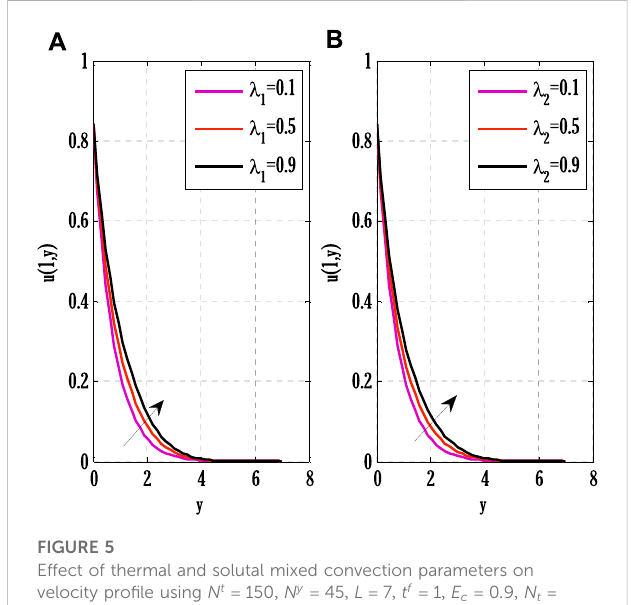
FIGURE 5 Effect of thermal and solutal mixed convection parameters on velocity pro fi le using N t (cid:2) 150 , N y (cid:2) 45 , L (cid:2) 7 , t f (cid:2) 1 , E c (cid:2) 0 . 9 , N t (cid:2) 0 . 1 , N b (cid:2) 0 . 15 , P r (cid:2) 1 , S c (cid:2) 1 , R d (cid:2) 0 . 1 , M (cid:2) 0 . 9 , β (cid:2) 3 , F r (cid:2) 1 . 5 , μ 1 (cid:2) 0 . 05 , λ (cid:2) 0 . 5 , μ 2 (cid:2) 0 . 1 , γ (cid:2) 0 . 9 (A) λ 2 = 0.1 (B) λ 1 = 0.1.